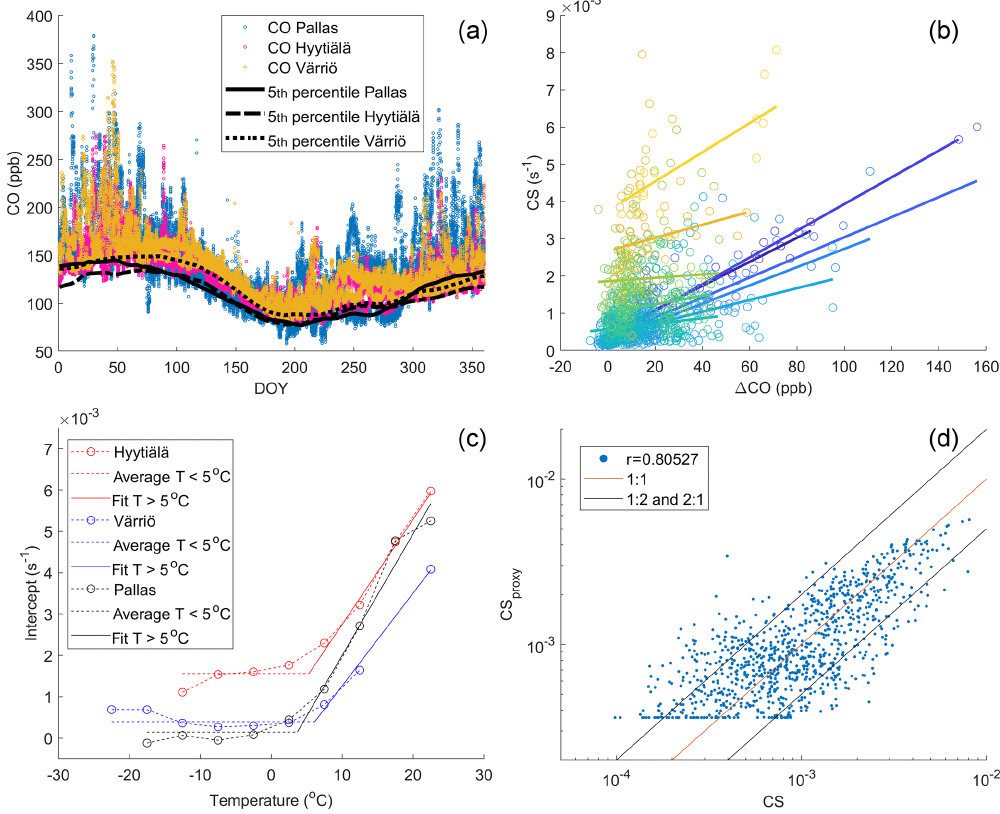
Figure 29. Derivation of the proxy for condensation sink (CS) based on the carbon monoxide (CO) concentration and air temperature. (a) Annual pattern of CO concentration and its 5th percentiles at the observation sites, (b) observed CS in Värriö as a function of the difference between observed CO and the 5th percentiles from panel (a) in 5 ◦ C temperature bins (blue colors for T < 5 ◦ C, green and yellow for T > 5 ◦ C), (c) intercepts a i (T ) in fittings to the data in panel (b) when slopes are forced to their average b ave as functions of temperature, and (d) the resulting proxy as shown in Eq.